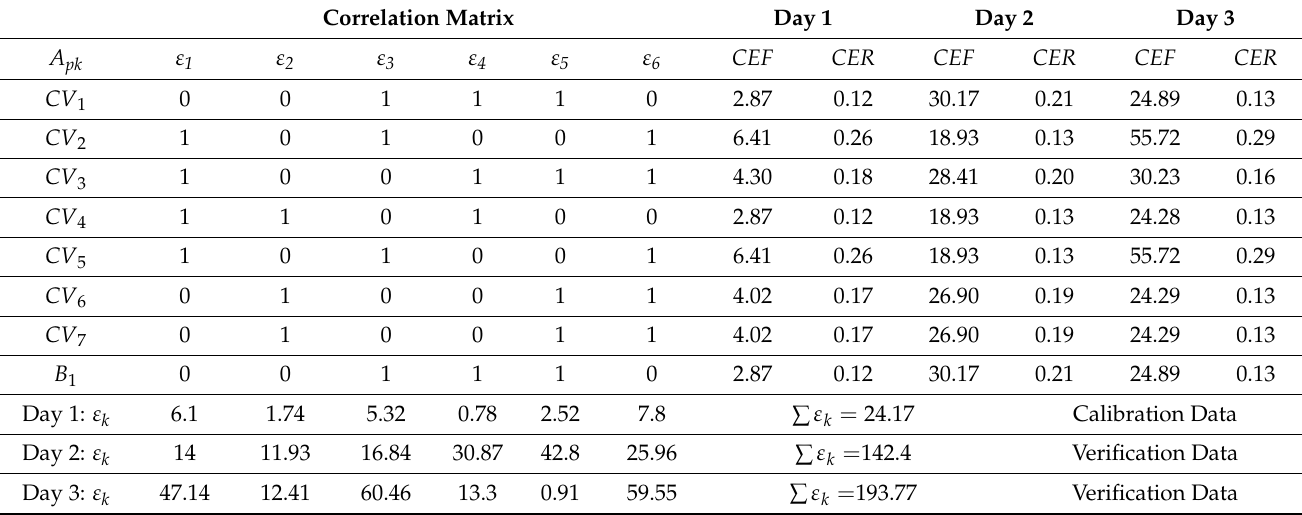
Table 5. Correlation matrix and error calculations for 3-day operational data. Correlation